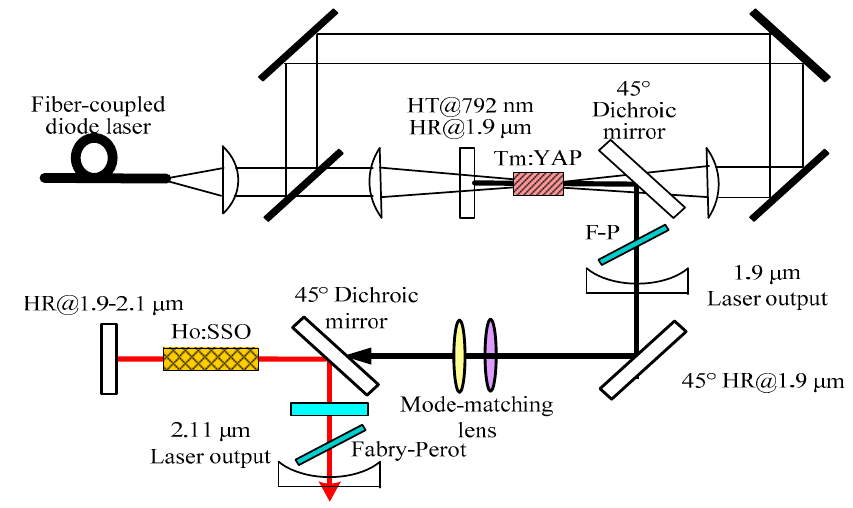
Figure 1. Experimental setup of an single ‐ longitudinal ‐ mode (SLM) Ho:Sc 2 SiO 5 (Ho:SSO) laser resonantly pumped by a Tm:YAP laser.